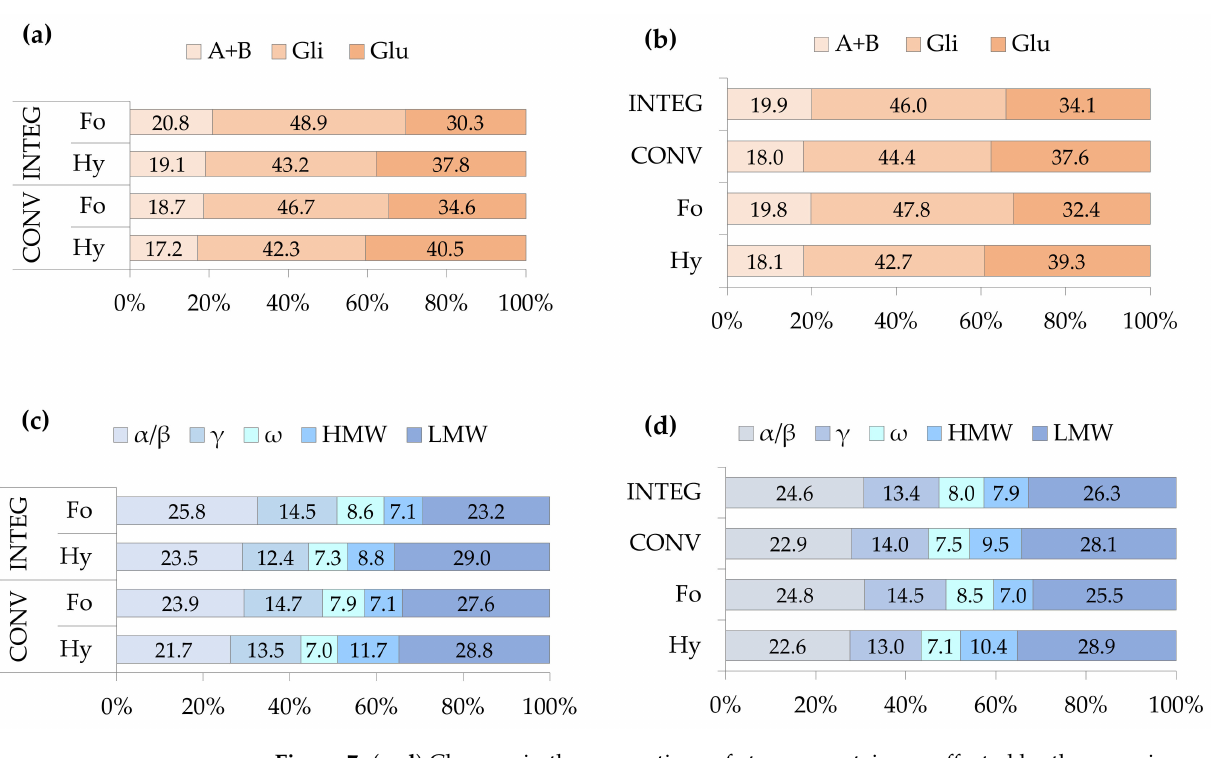
Figure 7. ( a – d ) Changes in the proportions of storage proteins as affected by the cropping system and cultivar (total protein = 100%). The presence of different lowercase letters indicates a statistical difference between means (Tukey’s Test, p = 0.05). A + B—albumins and globulins, Gli—gliadins,